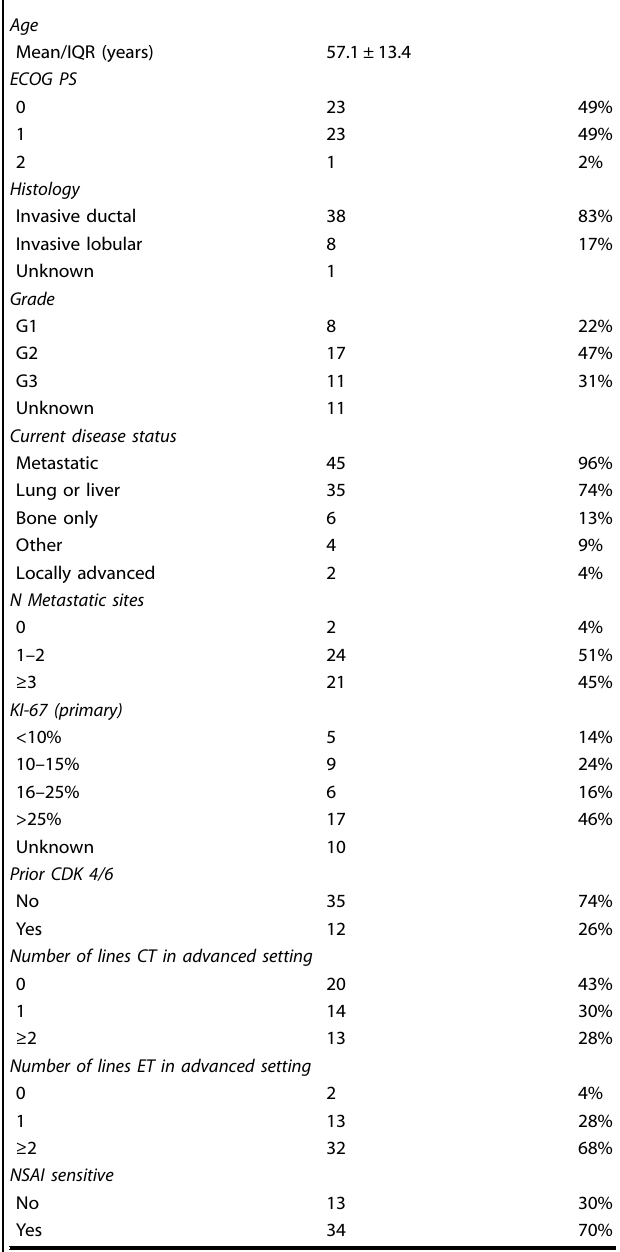
Table 1. Detailed patient characteristics ( n =